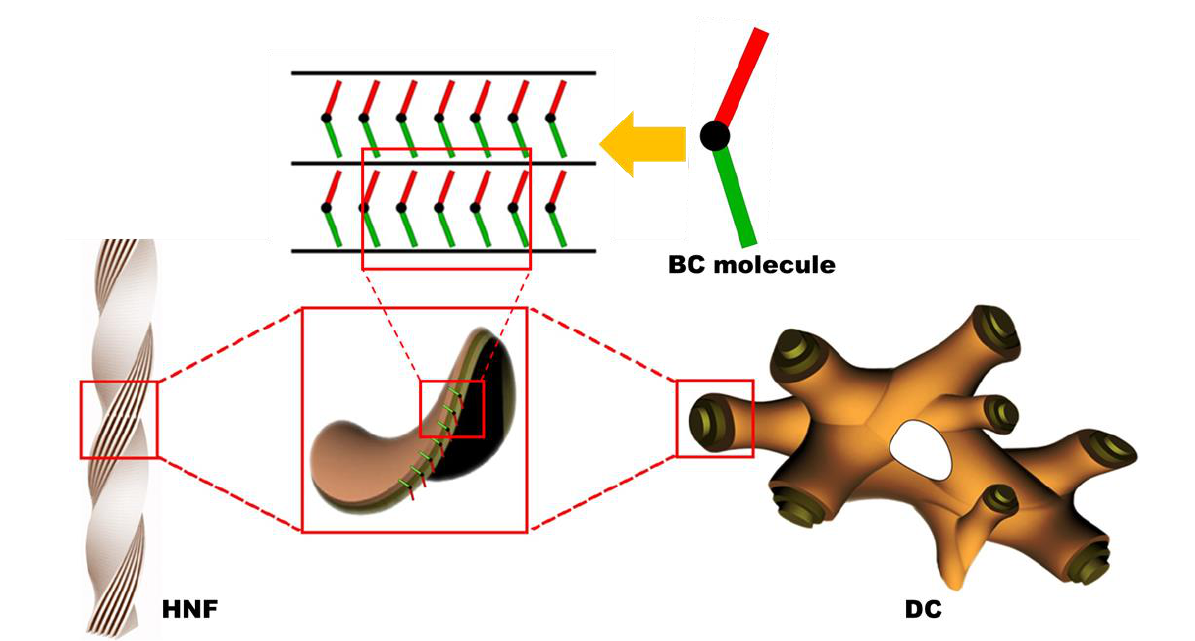
Figure 1. Schematics of the helical nanofilament (HNF) and dark conglomerate (DC) structures. Owing to the intralayer mismatching of the two arms of the molecules and the spontaneous tendency for saddle-splay curvature formation, either HNF or DC structures are assembled [12,16].